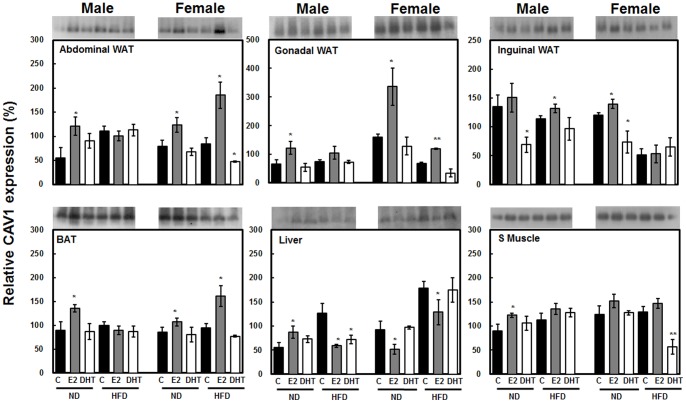
CAV1 was differentially expressed in tissues upon treatments with high fat diet and sex steroid hormones (E2 and DHT) in a sex-dependent manner.Band densities were normalized using β-actin in each tissue to calculate relative intensity (%). Statistical significance between control and hormone treated groups were calculated by Student’s t-test, where, *p<0.05 and **p<0.01. The significance of the effects of sex, diet and hormonal treatments was tested using multivariate ANOVA (M-ANOVA), where p<0.05.